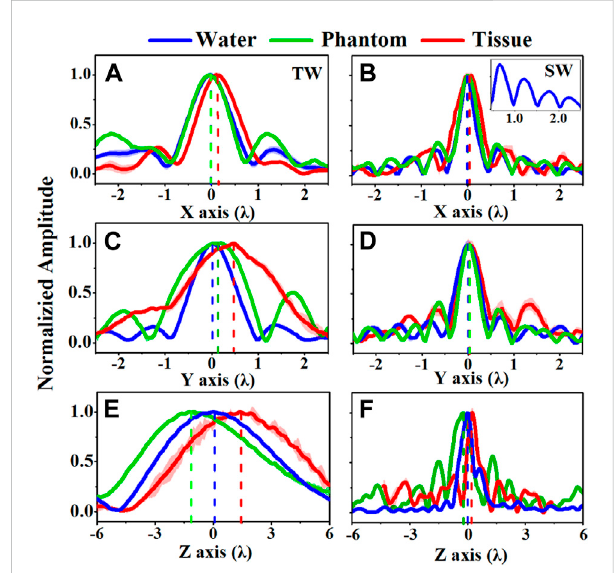
FIGURE 2 Comparison of the acoustic pressure distributions of (A, C, E) traveling wave (TW) by a concave transducer and (B, D, F) standing wave (SW) by a spherical cavity transducer along the X, Y, and Z axes when ultrasound propagates through water (blue curves), Phantom (green curves), and Tissue (blue curves), the inset in (B) showing the antinodes every half